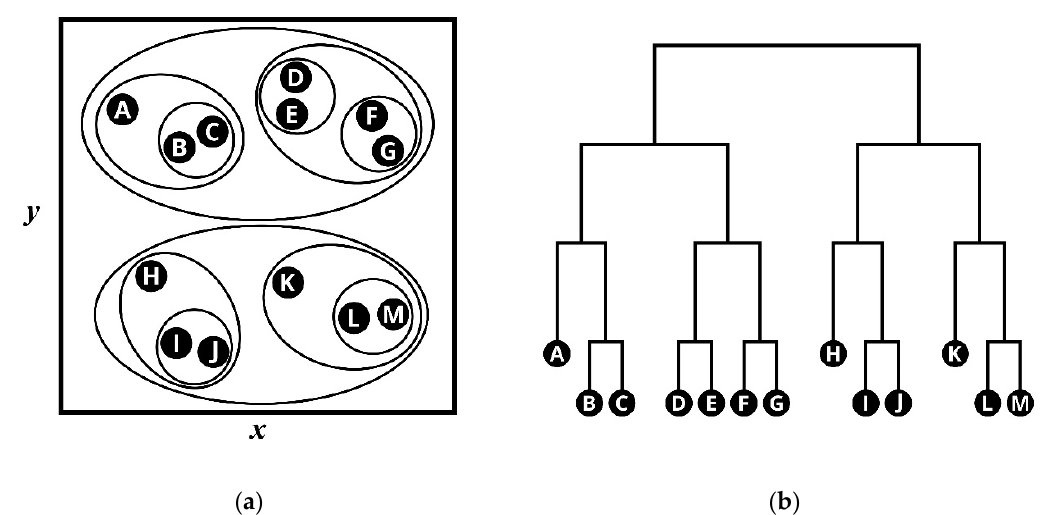
Figure 6. Conceptual illustration of hierarchical clustering: ( a ) nested clusters; ( b ) dendrogram.